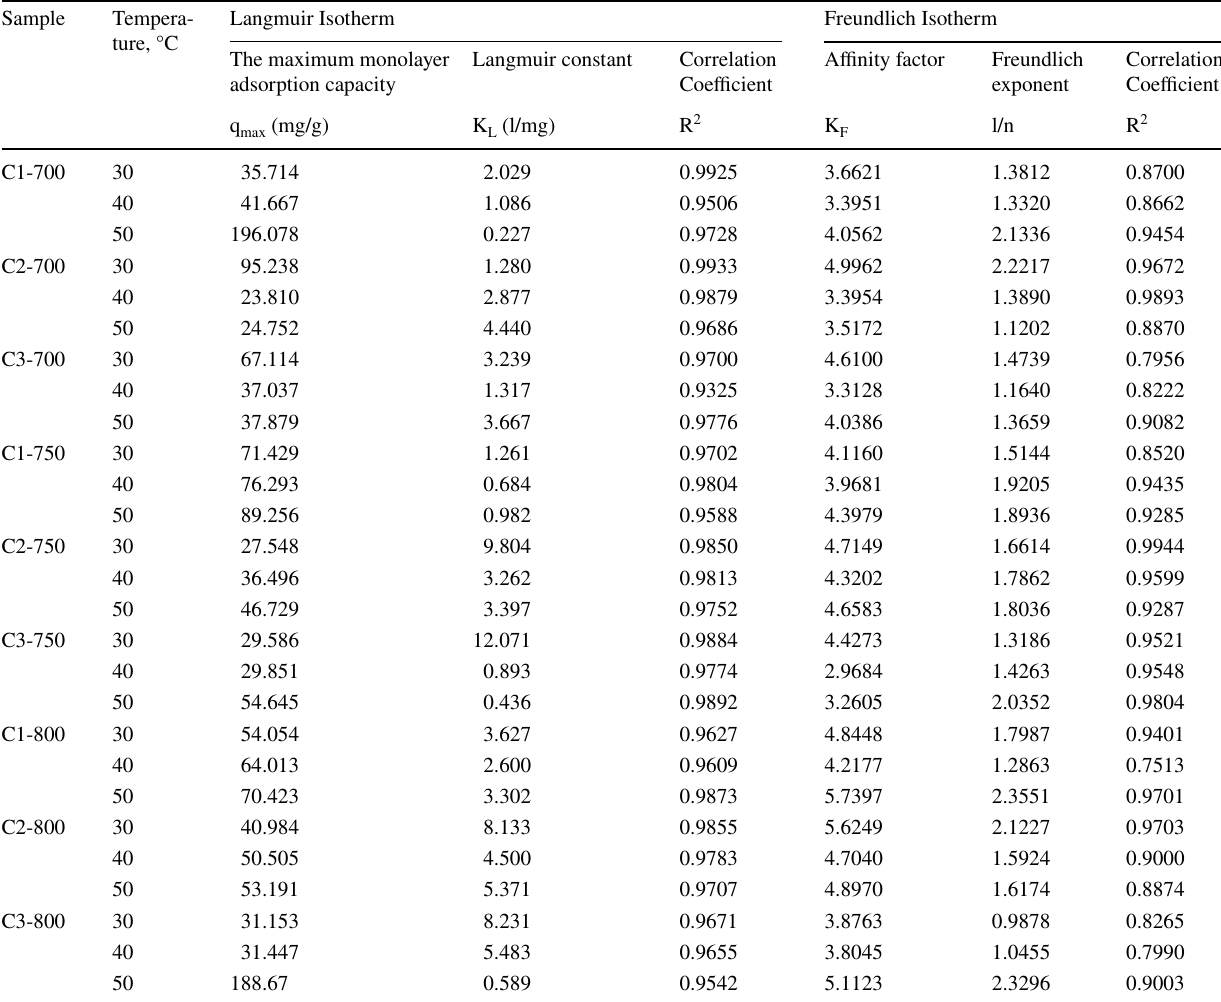
Table 5 Langmuir and Freundlich isotherm models for the adsorption of cadmium at all activation temperatures